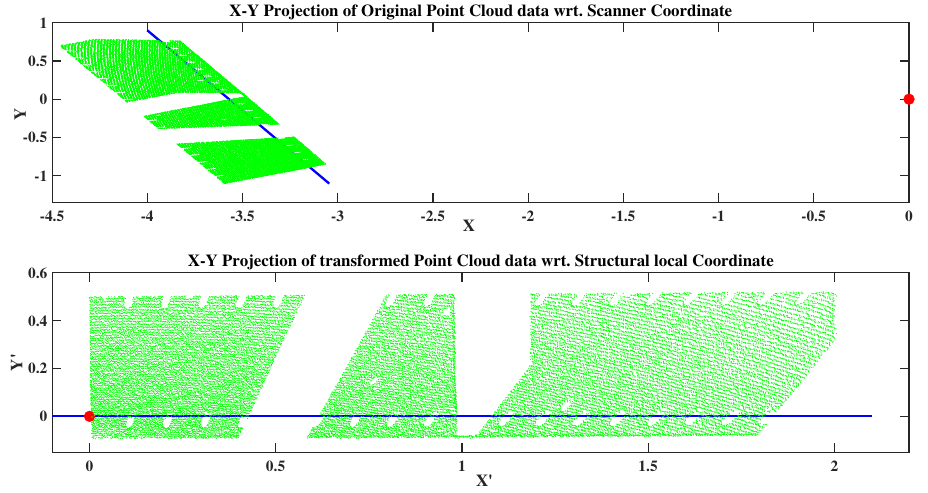
Figure 10. Flange point cloud before and after transformation of the